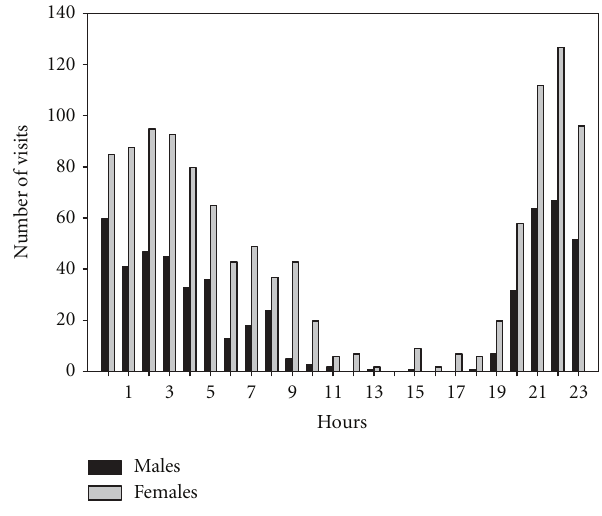
Figure 4: Timing of visits to water sources by identified male and female mule deer during summer (July and August) in western Utah, USA,